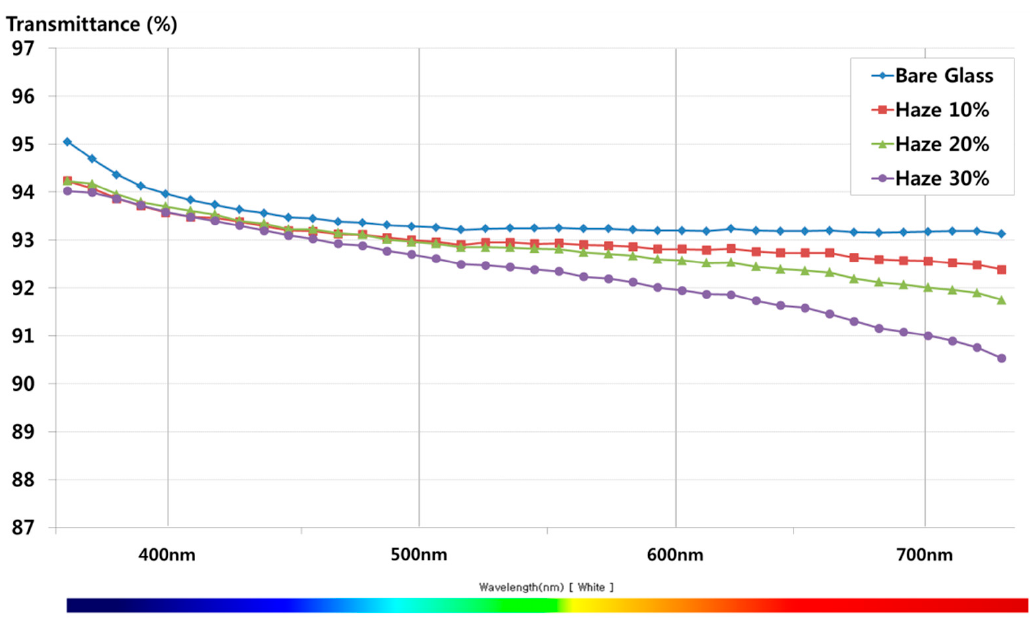
Figure 10. Transmittance analysis plot for various haze targets.